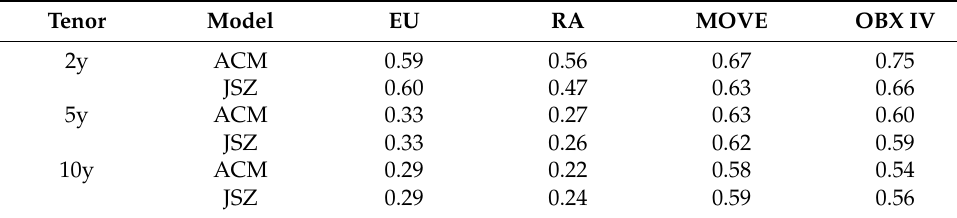
Table 3. Correlation of term premia estimates to fundamental risk